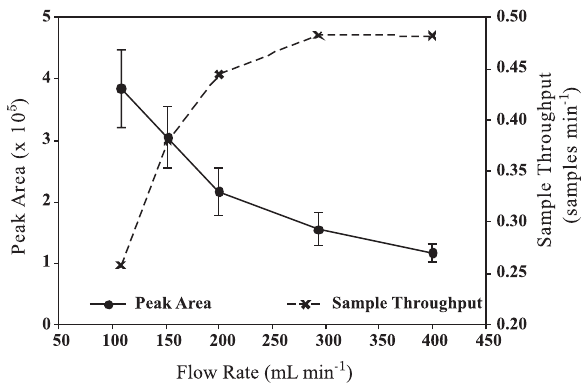
figure 4. the effect of nitrogen carrier flow rate on peak area and peak width at half height (mean ± sd, n =